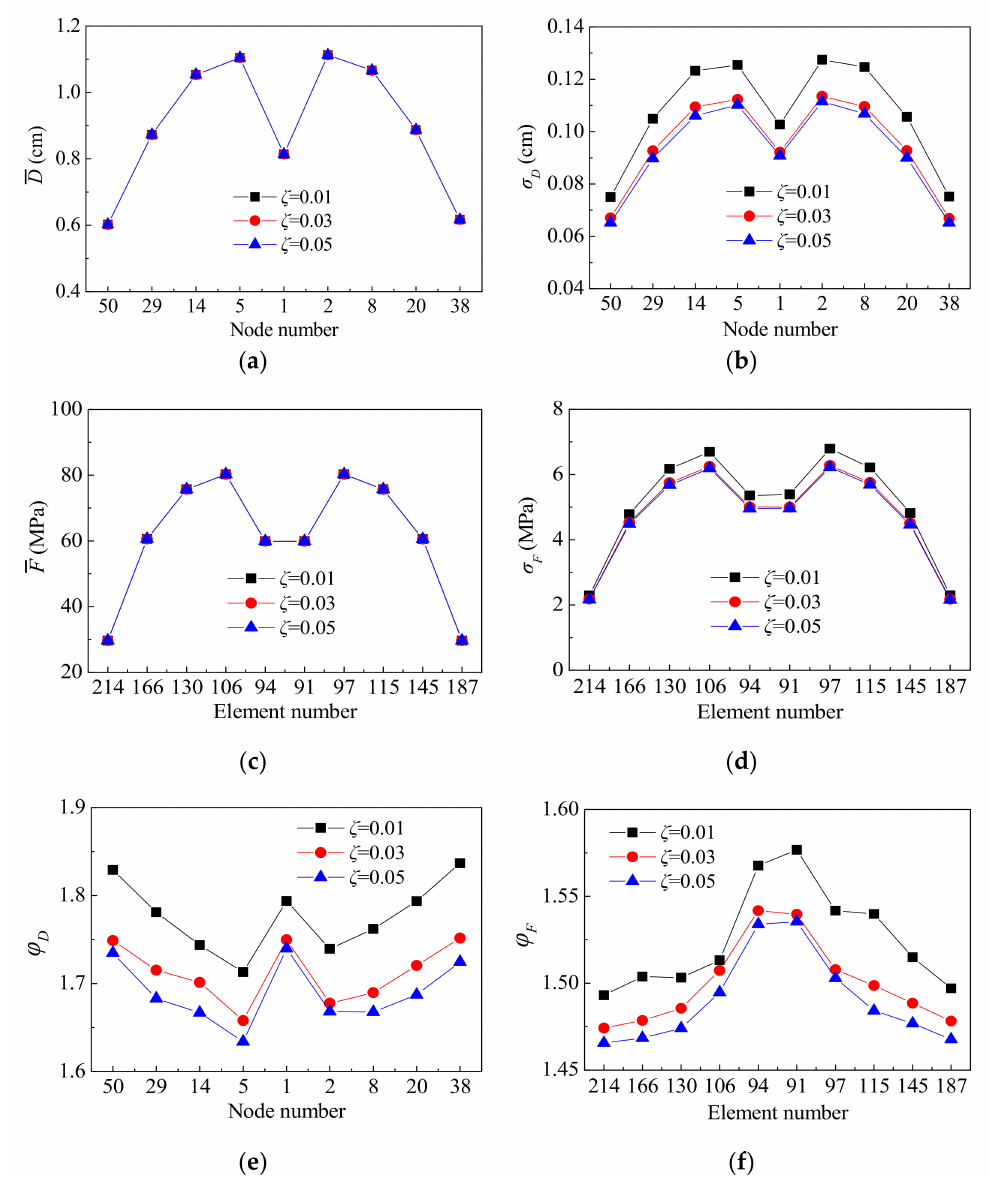
Figure 6. Structural responses versus different damping ratios: ( a ) mean displacements of nodes; ( b ) mean square displacements of nodes; ( c ) mean internal forces of elements; ( d ) mean square internal forces of elements; ( e ) DVCs of nodal displacement; ( f ) DVCs of elemental internal